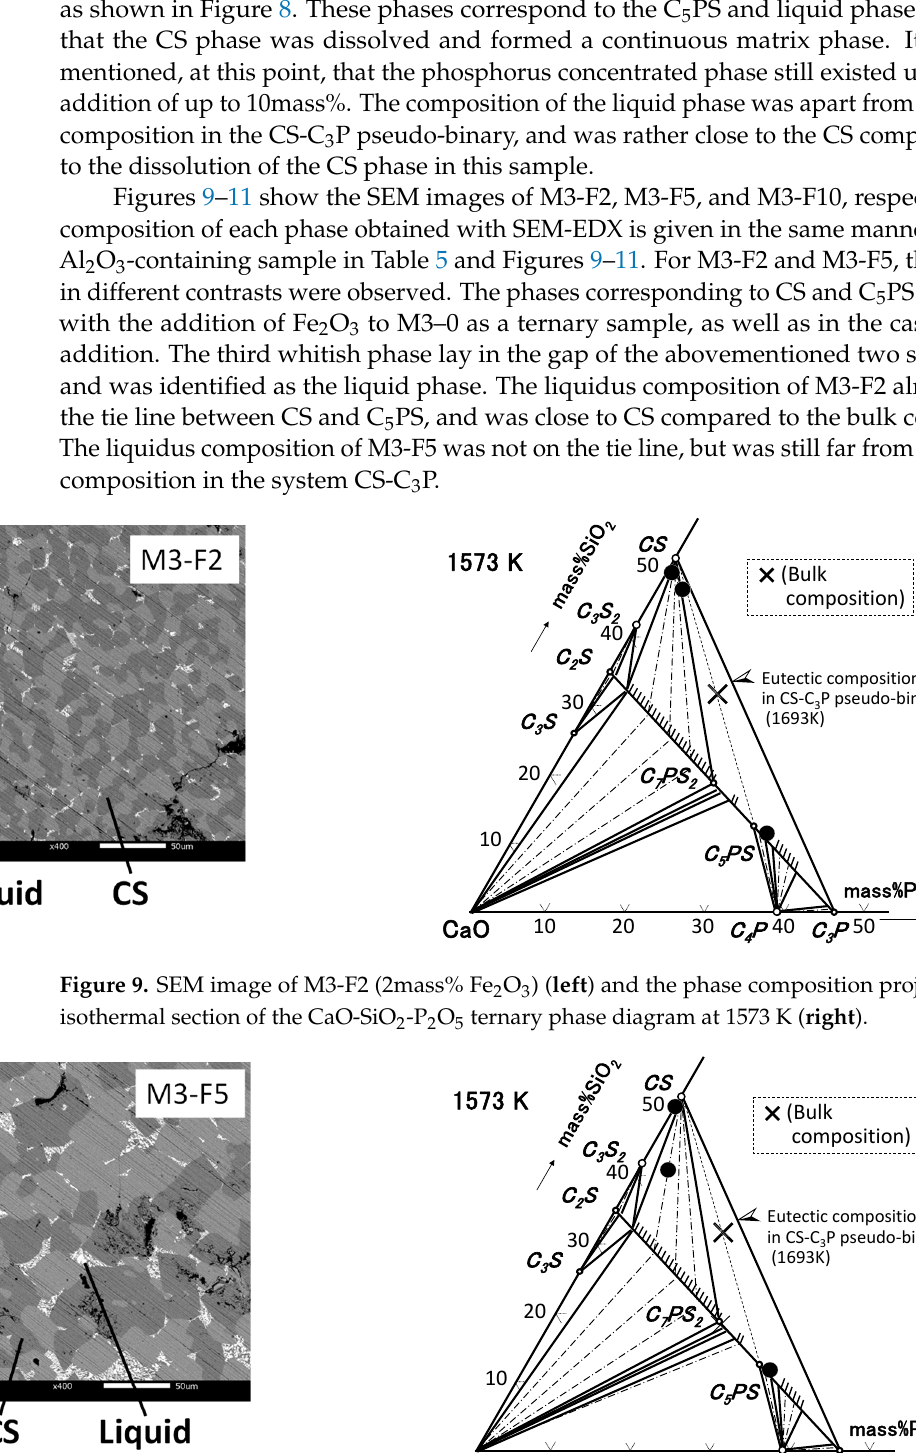
Liq 1 Estimated phase. Liq—liquid phase. For M3-A2 and M3-A5, three phases with different contrast were observed, as shown in Figures 6 and 7. Among them, the phases corresponding to CS and C 5 PS still existed, despite the addition of Al 2 O 3 to M3-0 as a ternary sample. The third phase, in the darkest color, was characterized by a Al